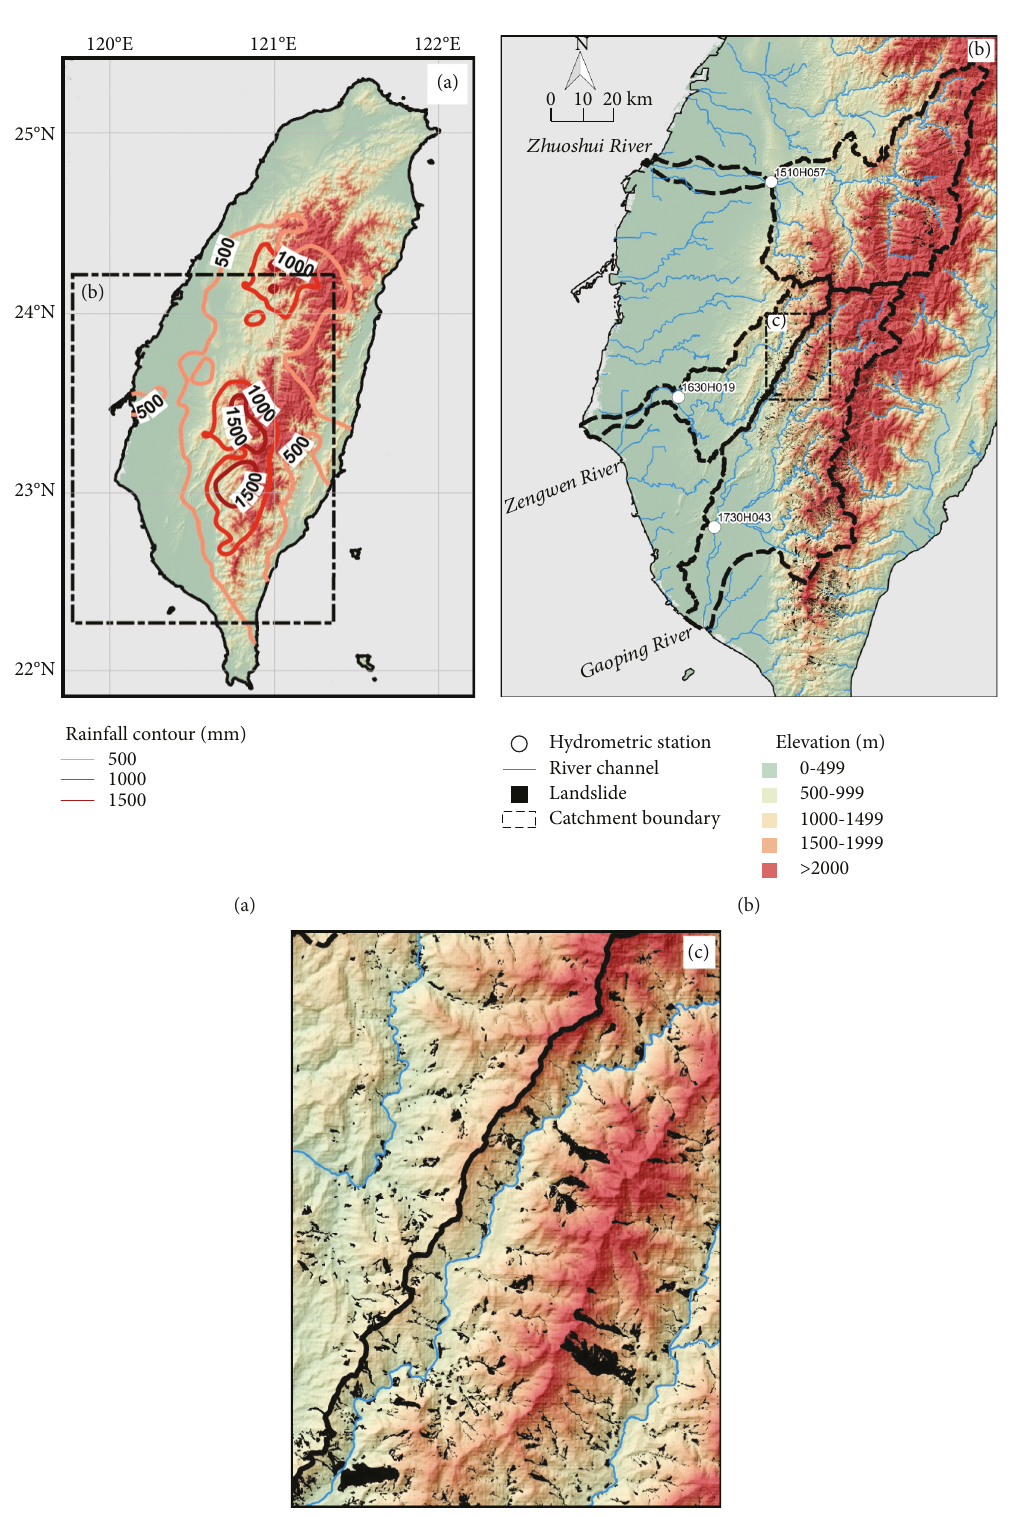
Figure 1: The rainfall and landslide distributions caused by Typhoon Morakot in 2009 and the 2009 annual suspended sediment discharges from the three rivers. (a) The contour lines represent the cumulative rainfall during the period from August 6 to 11, 2009. The numbers along the contour lines are the values of cumulative rainfall in mm. (b) The location of hydrometric stations and the boundaries of the three rivers. (c) Zoom-in view of landslide distribution around the boundary between the Zengwen River and the Gaoping